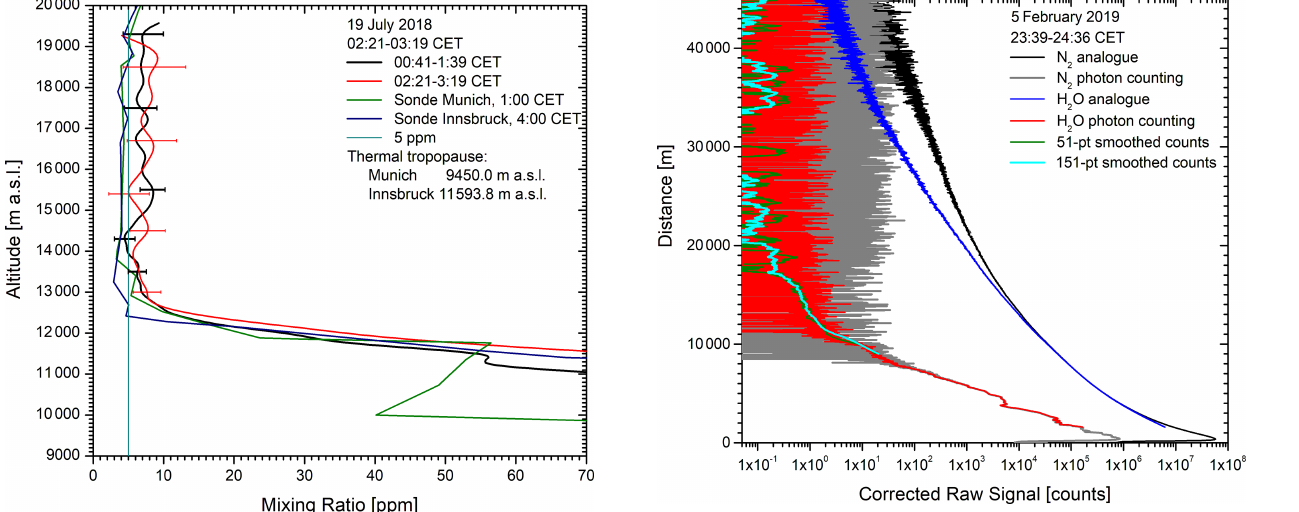
Figure 13. Comparison of the two lidar measurements on 19 July 2018, and the Innsbruck sonde on a close-up scale: the lidar values agree well up to 18km, ranging between 5 and 12ppm. The mixing ratio for the radiosondes (presumably RS41) is much lower than that for the lidar in the stratosphere.